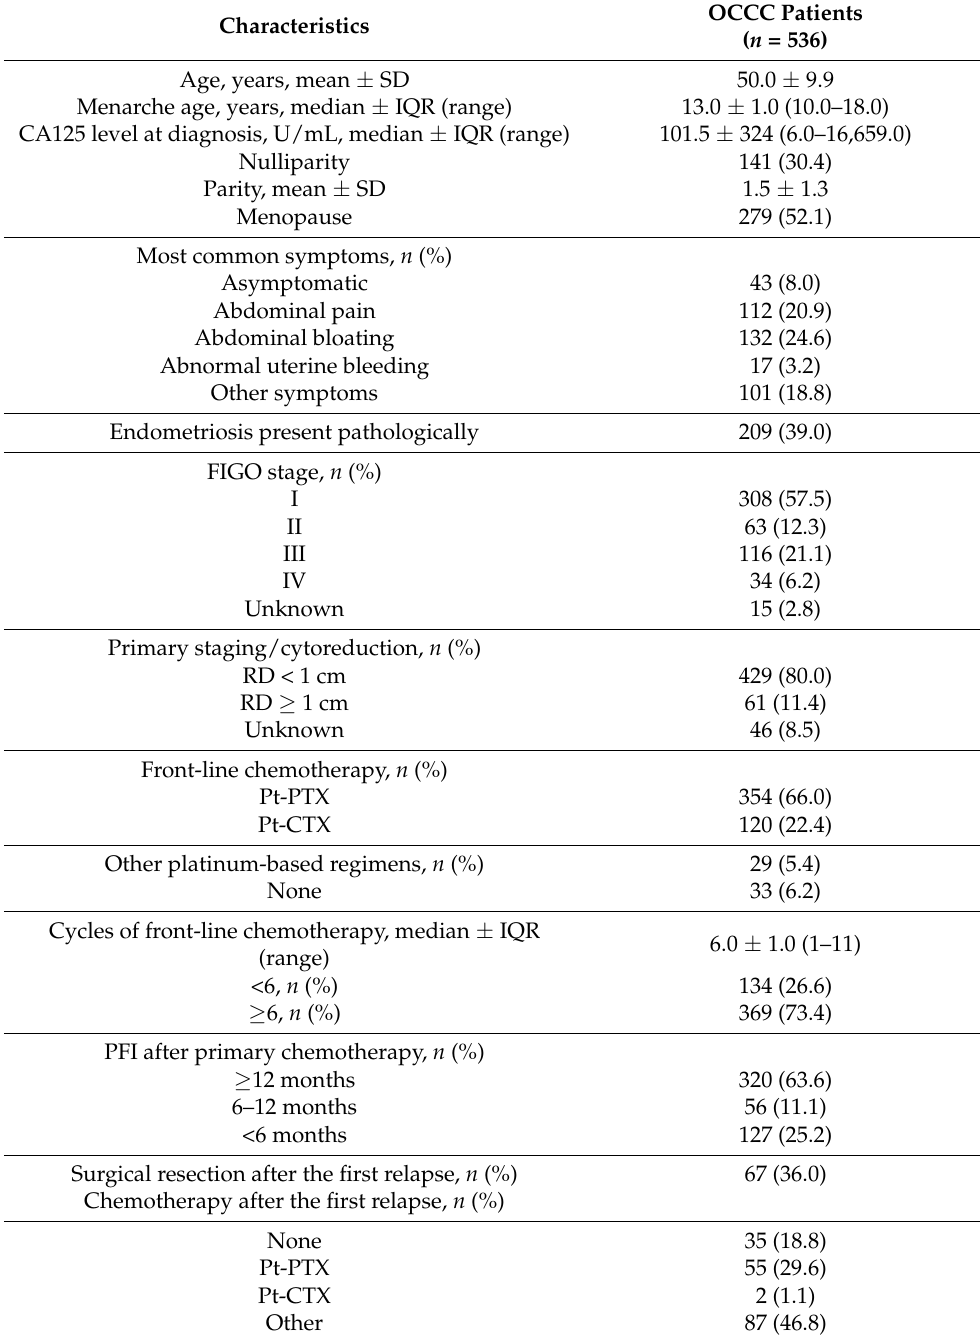
Table 1. Patient